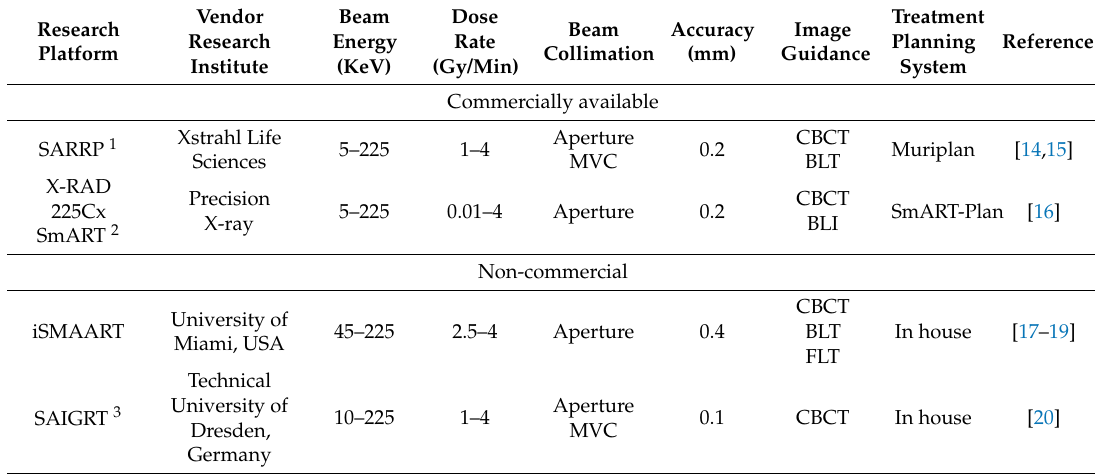
Table 1. Summary of small animal radiotherapy systems and individual characteristics.